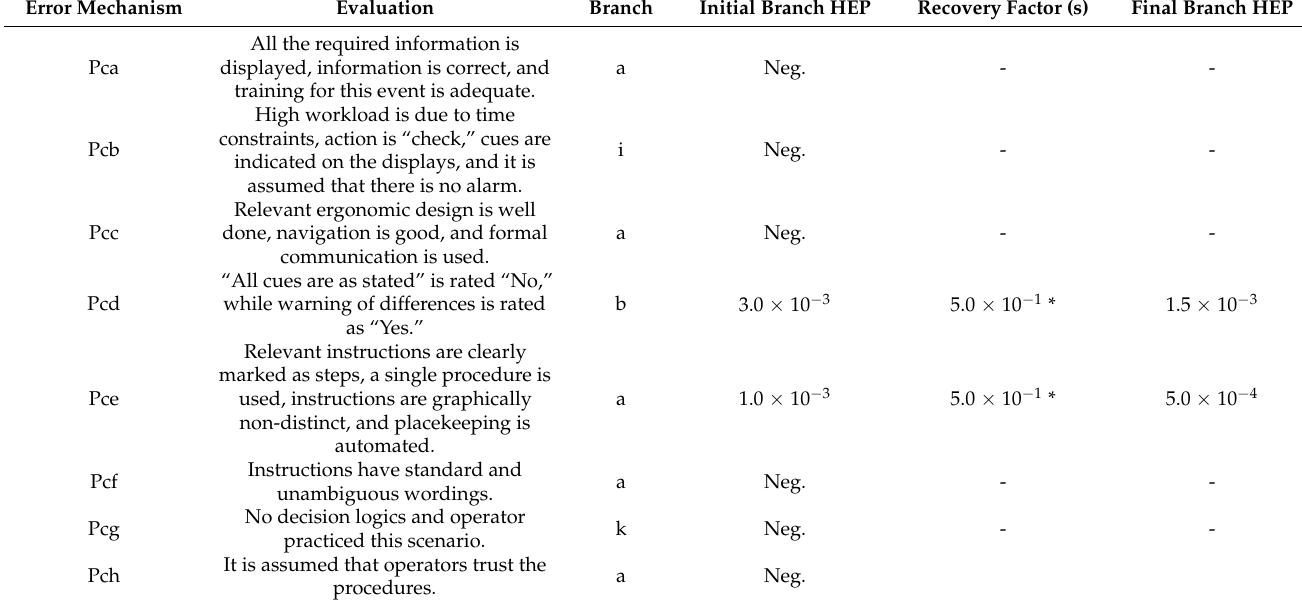
Table 8. Evaluating the diagnosis error for operator failure to initiate emergency boration. Error Mechanism